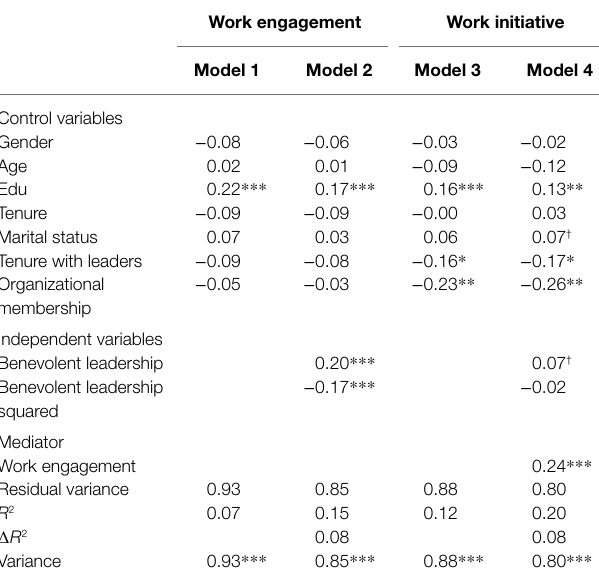
TABLE 5 | Unconflated multilevel model, individual level.